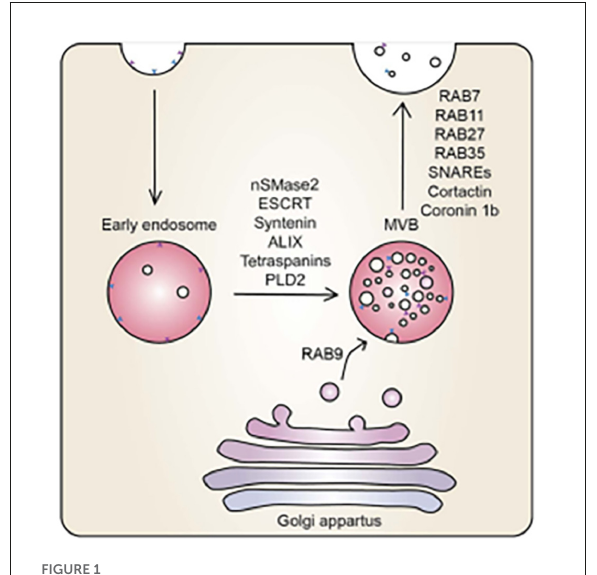
FIGURE1 The mechanistic underpinning of exosome biogenesis. Vesicles from the Golgi apparatus fuse with the endosomes to form MVBs, regulated by an array of sphinmyelinases and GTPases (McAndrews and Kalluri, 2019).